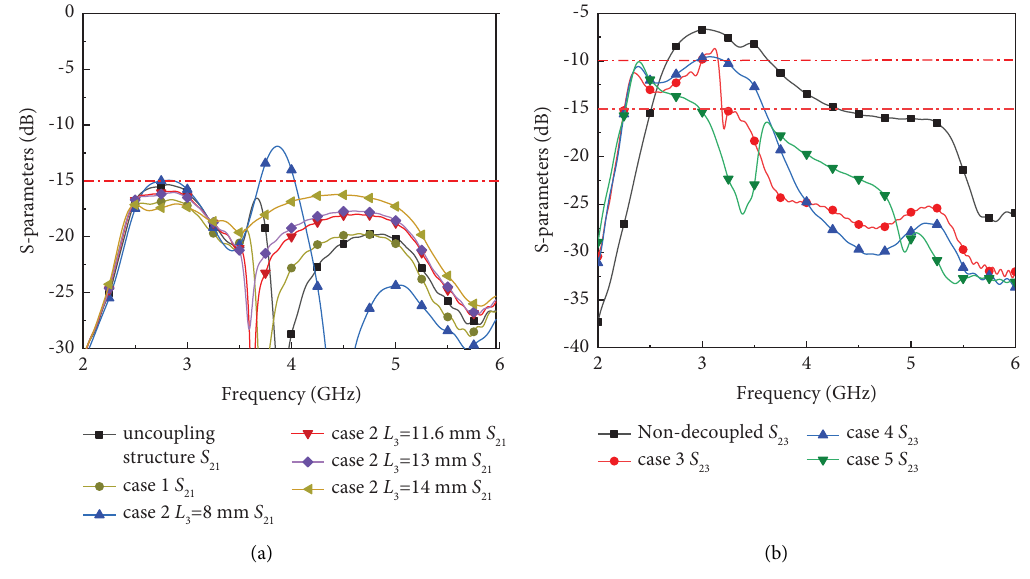
Figure 10: Decoupling structure evolution